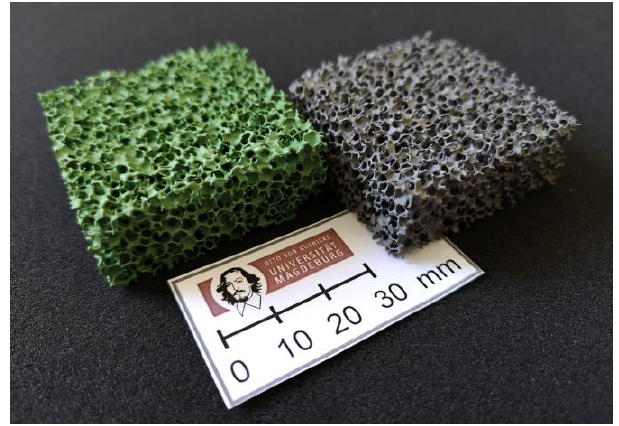
Figure 1. Specimens of NiO–YSZ (left) and Ni–YSZ cellular composites (right). The ratio of NiO and YSZ is 1:1 by weight. Before reduction, the foams possess the typical green color of NiO, which transforms to grey after reduction to metallic Ni.